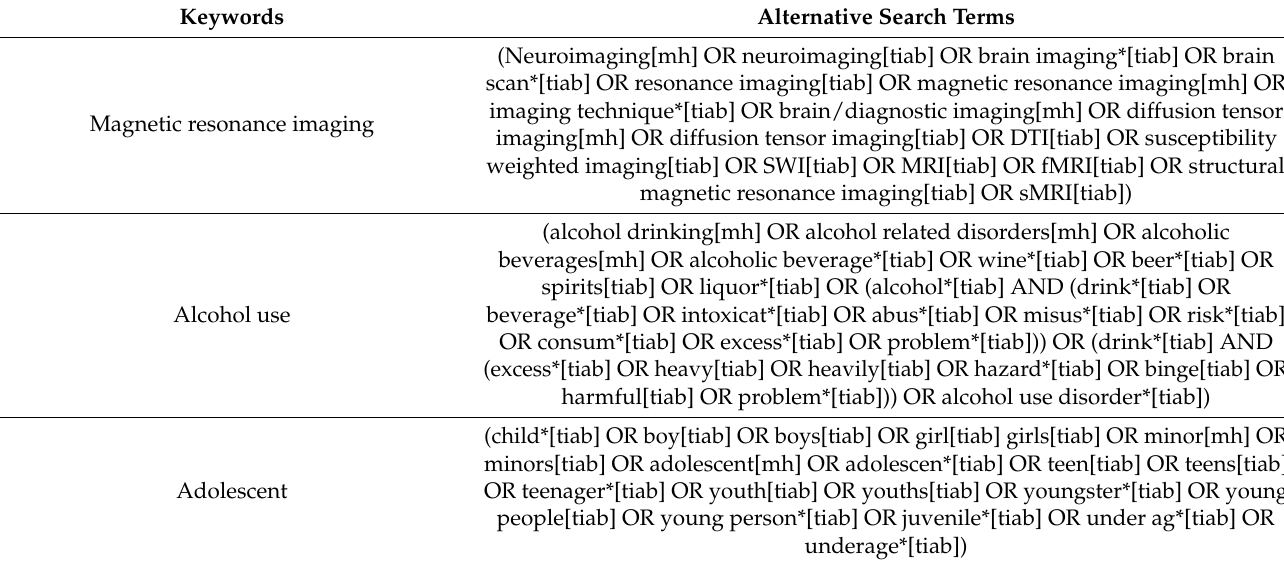
Table 1. Search strategy terms combined with the Boolean operator